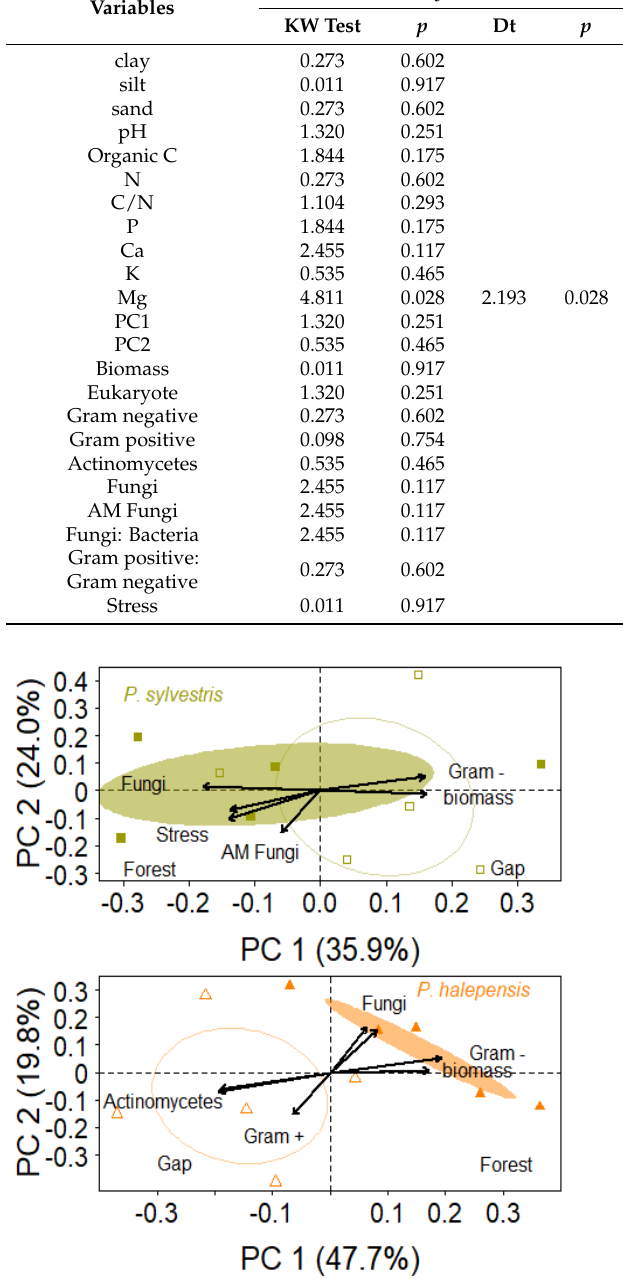
Table 2. Differences in physical (soil texture) and chemical (pH, nutrients concentration) charac- teristics and microbial community composition between gaps and closed-canopy patches in the P. sylvestris and the P. halepensis sites. For each variable, the results of the Kruskal–Wallis test (KW test) and associated probability ( p ) are shown. When significant differences ( p < 0.05) were found the Dunn’s test ( Dt ) was used to assess differences. Negative Dt values indicate higher values in gaps than in closed-canopy stands, whereas positive Dt values indicate higher values in closed-canopy stands. Pinus sylvestris Pinus halepensis Variables